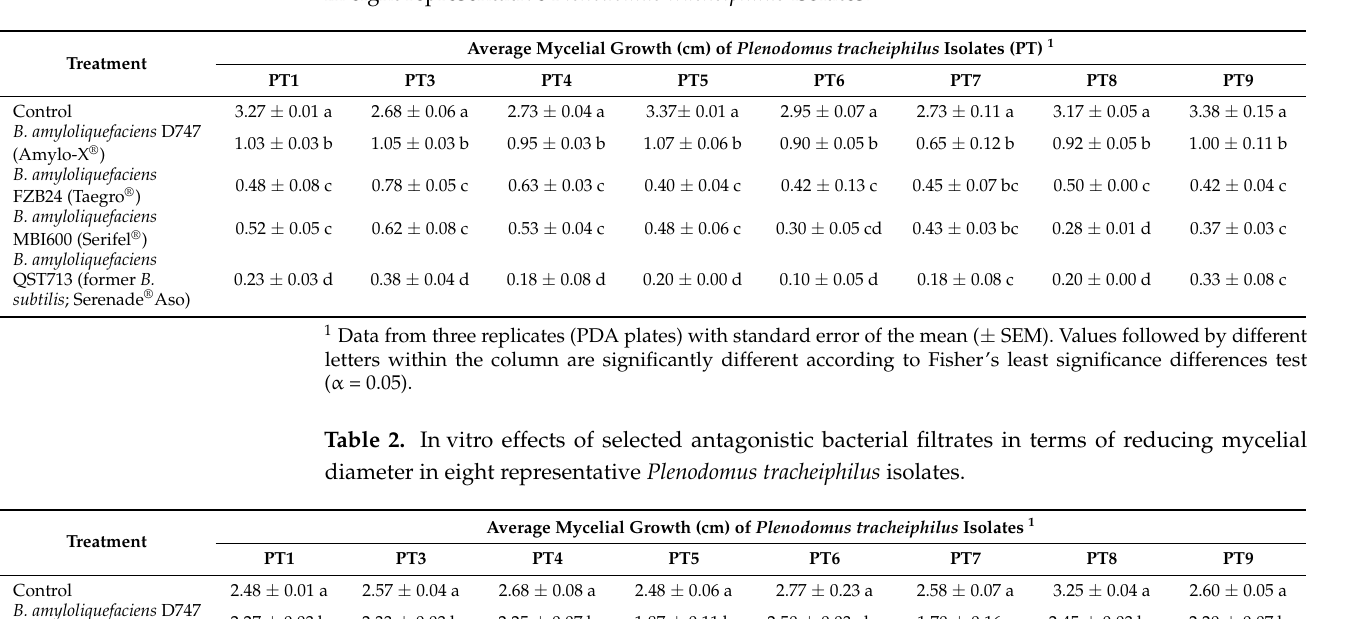
Table 1. In vitro effects of selected antagonistic bacterial cells in terms of reducing mycelial diameter in eight representative Plenodomus tracheiphilus isolates.